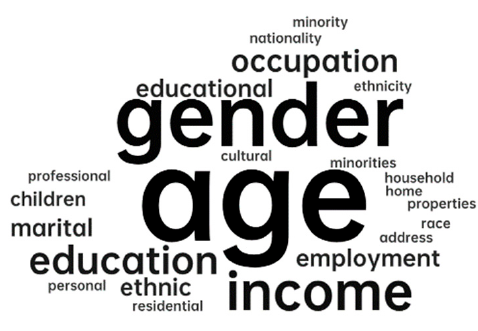
Figure 6. Word density cloud of sociodemographic characteristics.